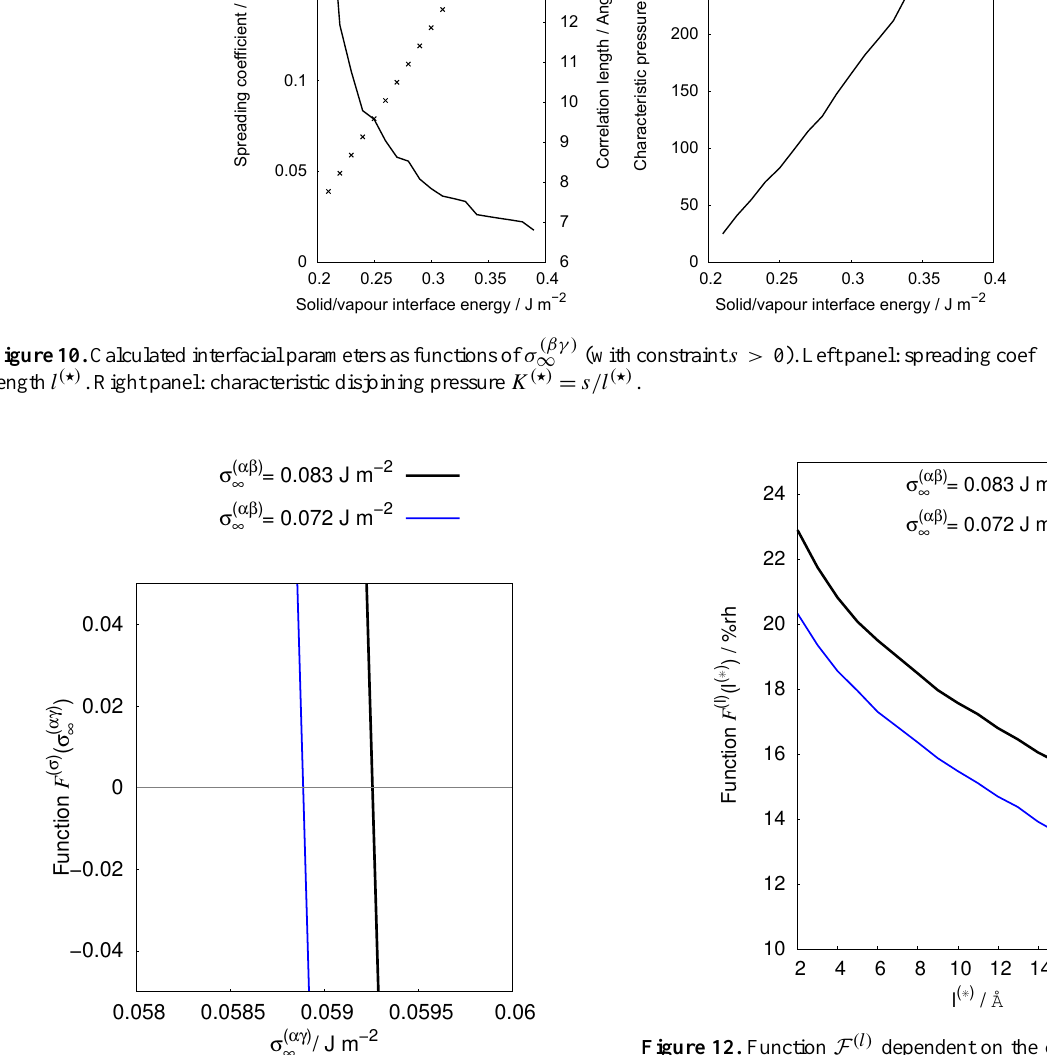
Figure 12. Function F (l) dependent on the correlation length l ((cid:63)) according to Eq. (8), employing the “ideal solution” limit of the activity model for two different σ (αβ) ∞ values. Black graph uses σ (αβ) ∞ = 0 . 083Jm − 2 ; blue graph uses σ (αβ) ∞ = 0 . 072Jm − 2